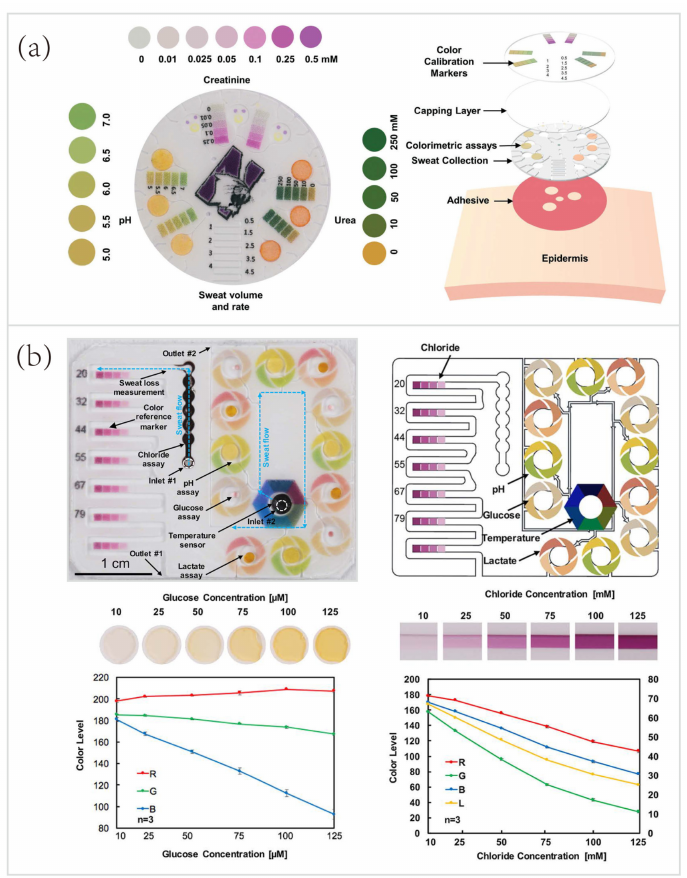
Figure 7. Microfluidic biosensor for colorimetric sensing biomarkers in sweat. ( a ) A soft microfluidic biosensor for colorimetric analysis of biomarkers relevant to kidney function. A top view of its layout and targeted biomarkers, and an exploded view of its di ff erent layers and components [34]. Copyright 2019, Royal Society of Chemistry. ( b ) A soft, skin-interfaced multifunctional microfluidic biosensor for accurate colorimetric sensing of sweat temperature, pH, chloride, glucose, and lactate. Two representative optical images of color development of assay microreservoirs as a function of sample concentrations and the corresponding RGB values of glucose and chloride [74]. Copyright